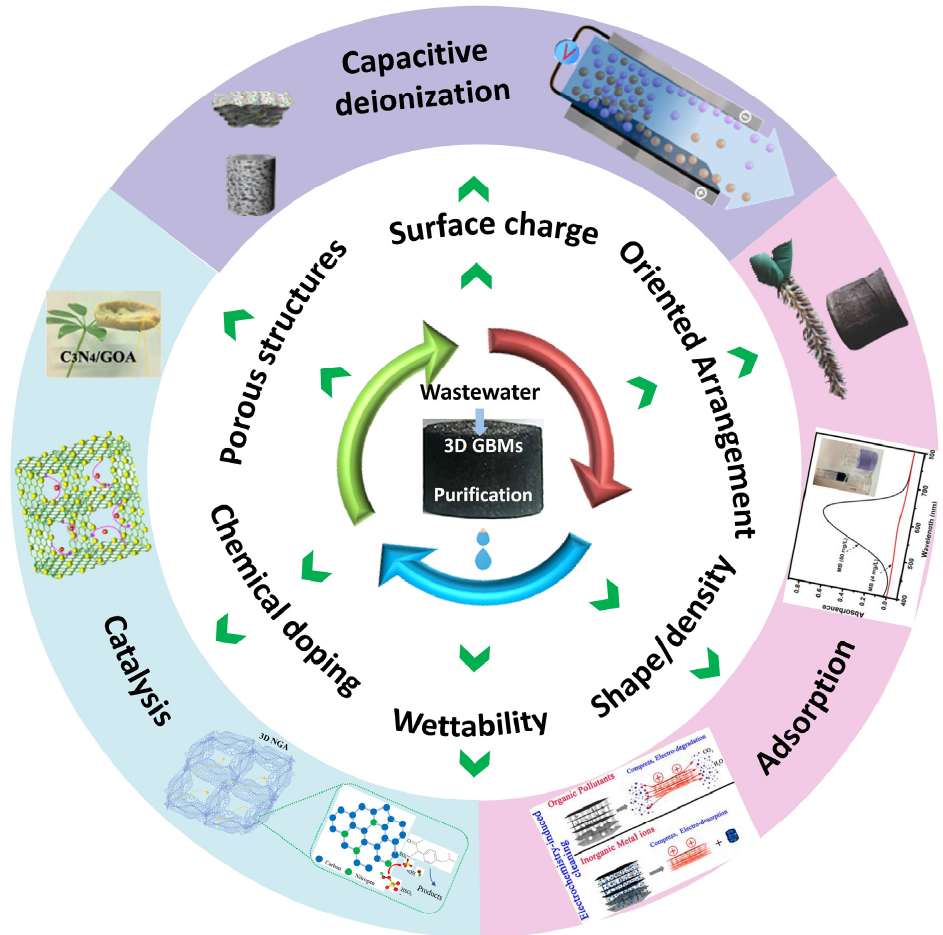
Figure 1. Schematic illustration of the structural manipulation of 3D GBMs for water purification